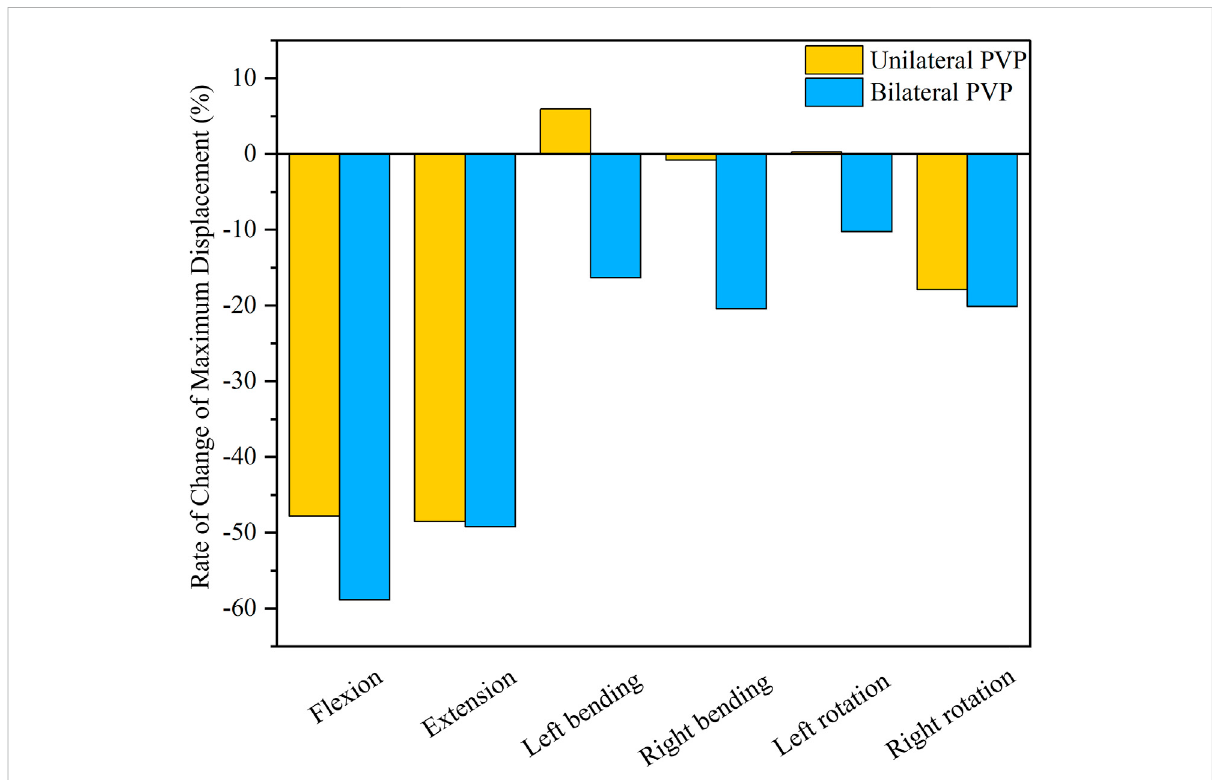
FIGURE 11 Rate of Change of Maximum Displacement of T12. Rate of Change of Maximum Displacement of T12 between UPVP and BPVP under fl exion, extension, left/right bending, and left/right